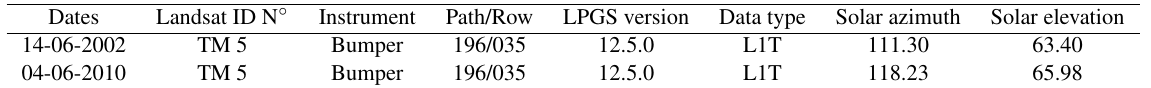
Table 2: Characteristics of the Landsat 5 images in the Algerian region.